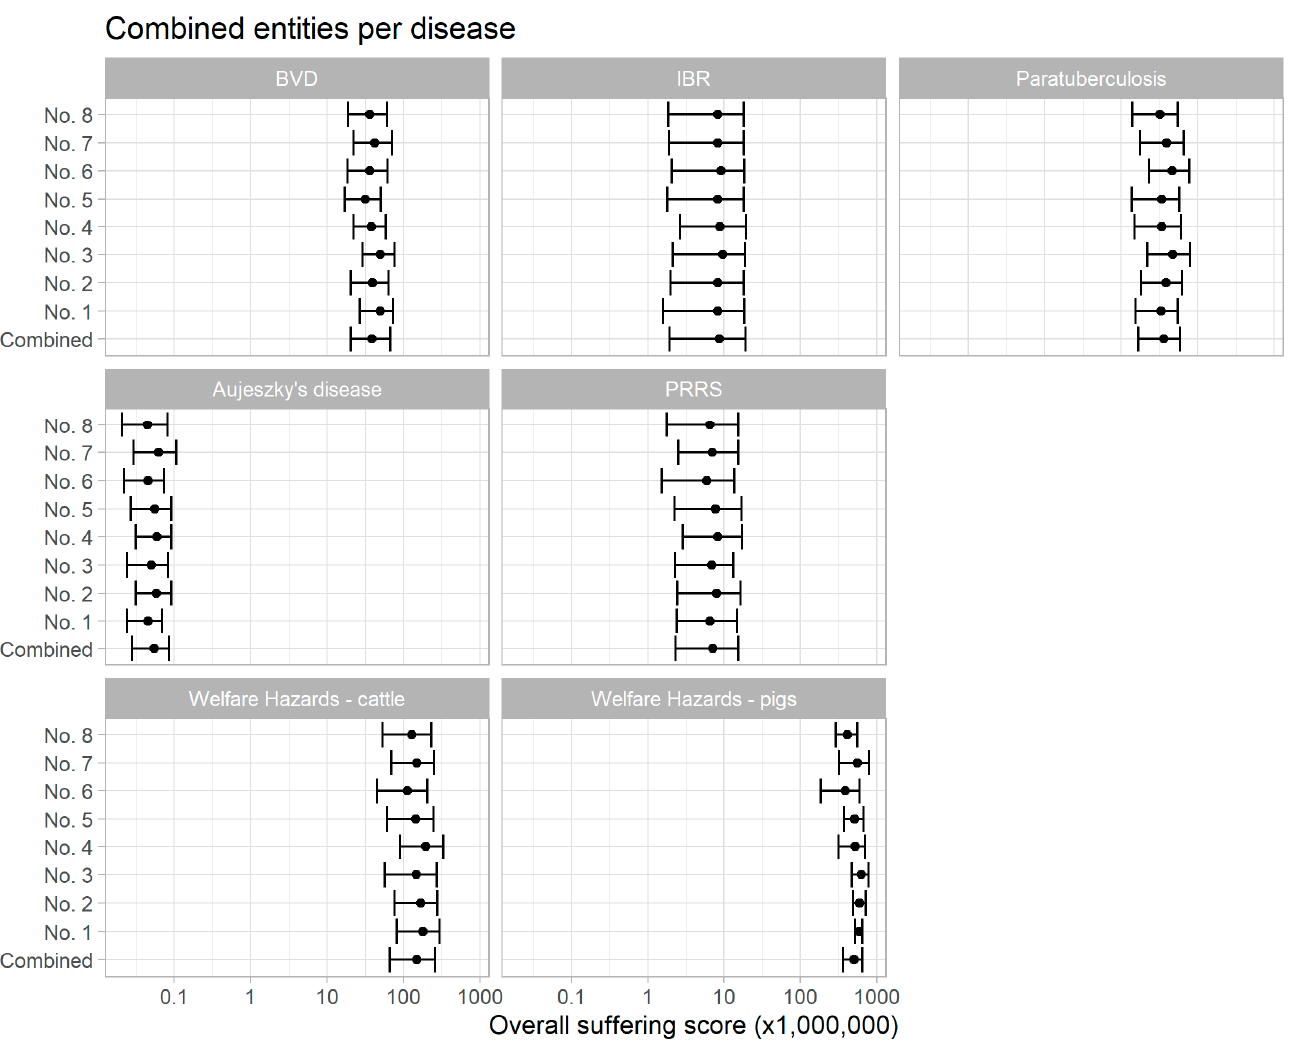
Figure 1. The aggregated suffering scores (2.5, 50, and 97.5 percentiles) given by eight experts (specified as No. 1–No. 8).